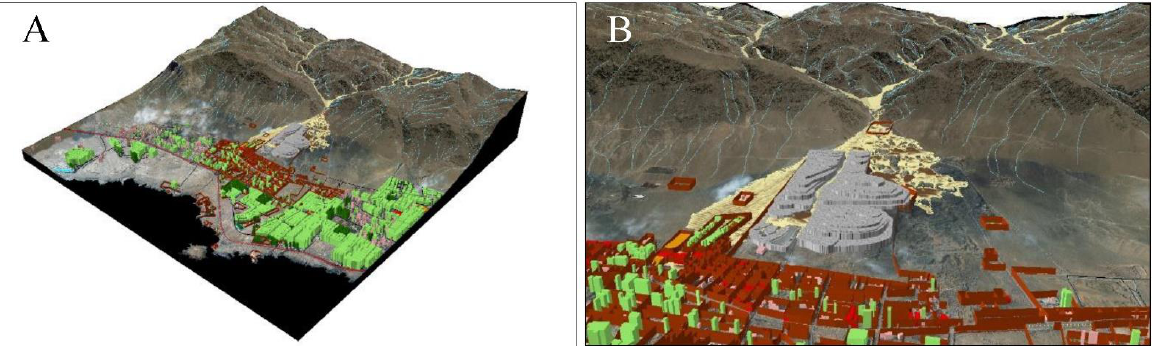
Figure 8. Debris flow impact map for the La Chimba basin in 3 dimensions. Results of RAMMS software modeling for maximum fluidity for a maximum debris flow of 110.29 m 3 in 1.5 h, representing the maximum intensity of the design rainfall event, with a return period of 200 years (Tr 200 ). The red, orange, pink, dark green and light green colors represent from a materiality with null or almost null resistance to a high resistance to landslides such as flows. ( A ) Overview. ( B ) Details of the mouth of the La Chimba basin. The different yellow colorations of the flow indicate the maximum heights of the debris flow.